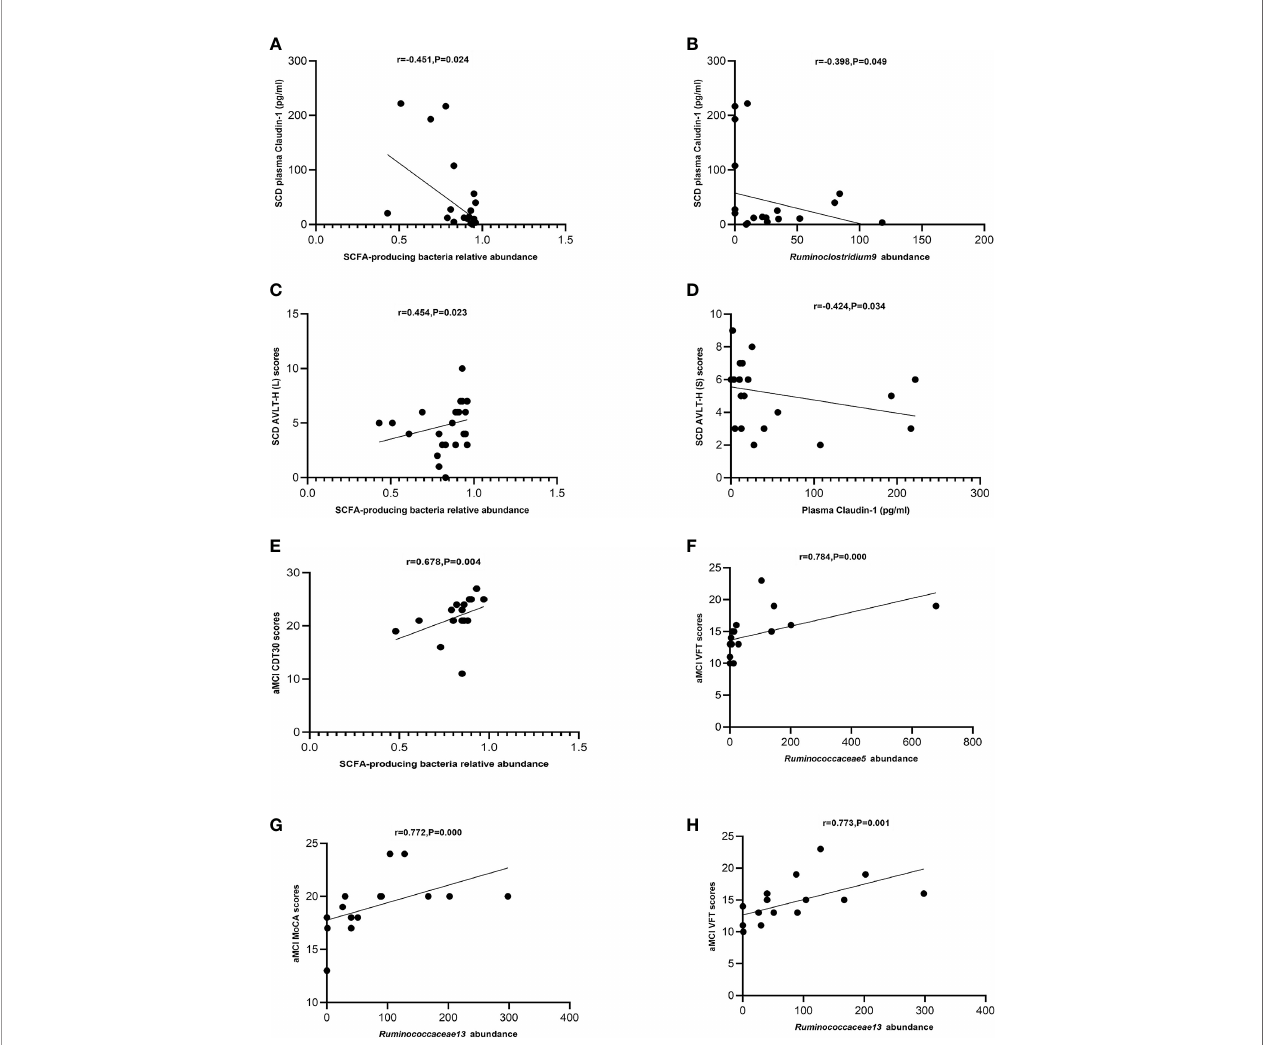
FIGURE 7 | (A – H) Spearman ’ s correlation analysis between SCFA-producing bacteria and tight junction proteins and neuropsychological assessment of pAD groups. (A) Spearman ’ s correlation analysis outcome shows that the concentration of plasma claudin-1 was negatively correlated with the relative abundance of the SCFA-producing bacteria in the SCD group (r = − 0.451, P = 0.024; Linear regression equation: Y = − 224.0*X + 224.5, P = 0.0229). (B) Spearman ’ s correlation analysis outcome shows that the concentration of plasma claudin-1 was negatively correlated with the relative abundance of the SCFA-producing bacteria Ruminoclostridium9 in the SCD group (r = − 0.398, P = 0.049; Linear regression equation: Y = − 0.5602*X + 57.64, P = 0.0962). (C) Spearman ’ s correlation analysis between the relative abundance of SCFA-producing bacteria and AVLT-H (L) scores in the SCD group (r = 0.454, P = 0.023; Linear regression equation: Y = 3.847*X + 1.610, P = 0.2345). (D) Spearman ’ s correlation analysis between the concentration of plasma caludin-1 and AVLT-H (S) scores in the SCD group (r = 0.424, P = 0.034; Linear regression equation: Y = − 0.008021*X + 5.555, P = 0.1623). (E) Spearman ’ s correlation analysis between the relative abundance of SCFA- producing bacteria and CDT30 in the aMCI group (r = 0.678, P = 0.004; Linear regression equation: Y = 12.68*X + 11.33, P = 0.1302). (F) Spearman ’ s correlation analysis between the relative abundance of SCFA-producing bacteria Ruminococcaceae5 and VFT scores in the aMCI group (r = 0.784, P= 0.000;